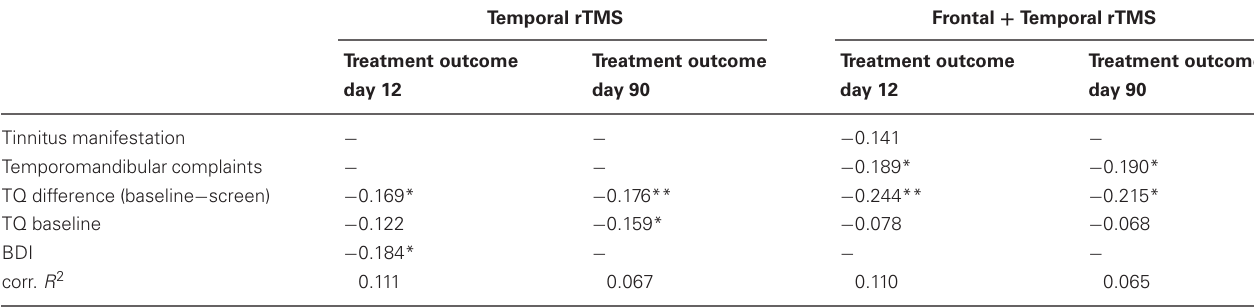
Table 3 | Results of multiple regression analyses for both treatment groups: standardized regression coefficients ( β